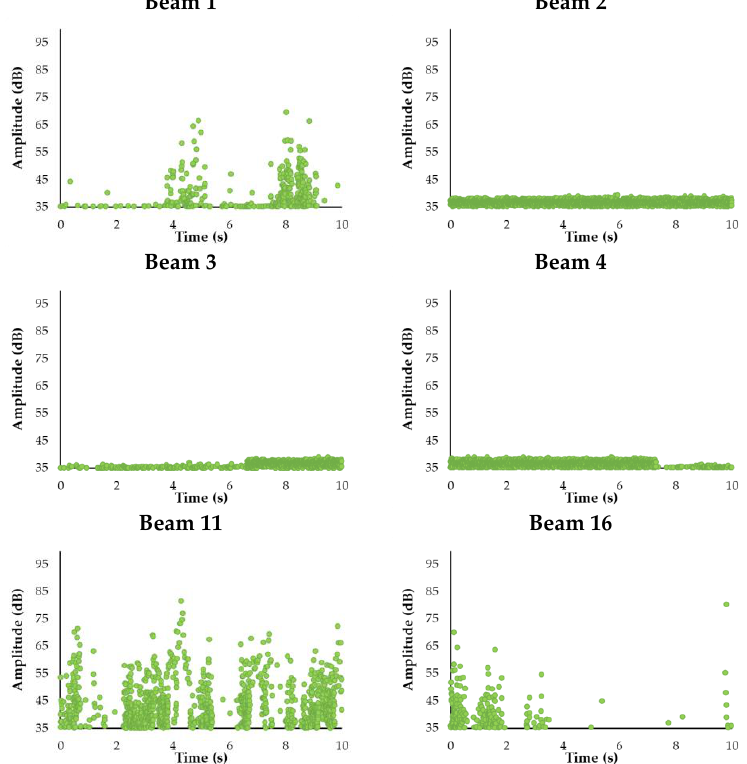
Figure 18. Amplitude of the signals recorded during 10 s on the beams with the active presence of xylophages as a function of time.